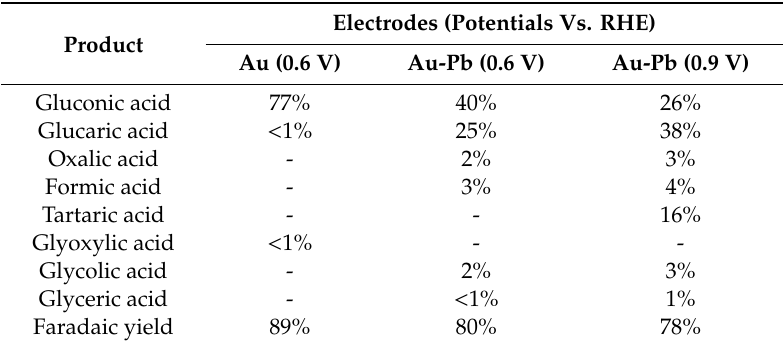
Table 4. Chemical and Faradaic yields for the electro-oxidation of glucose on gold and -modified gold